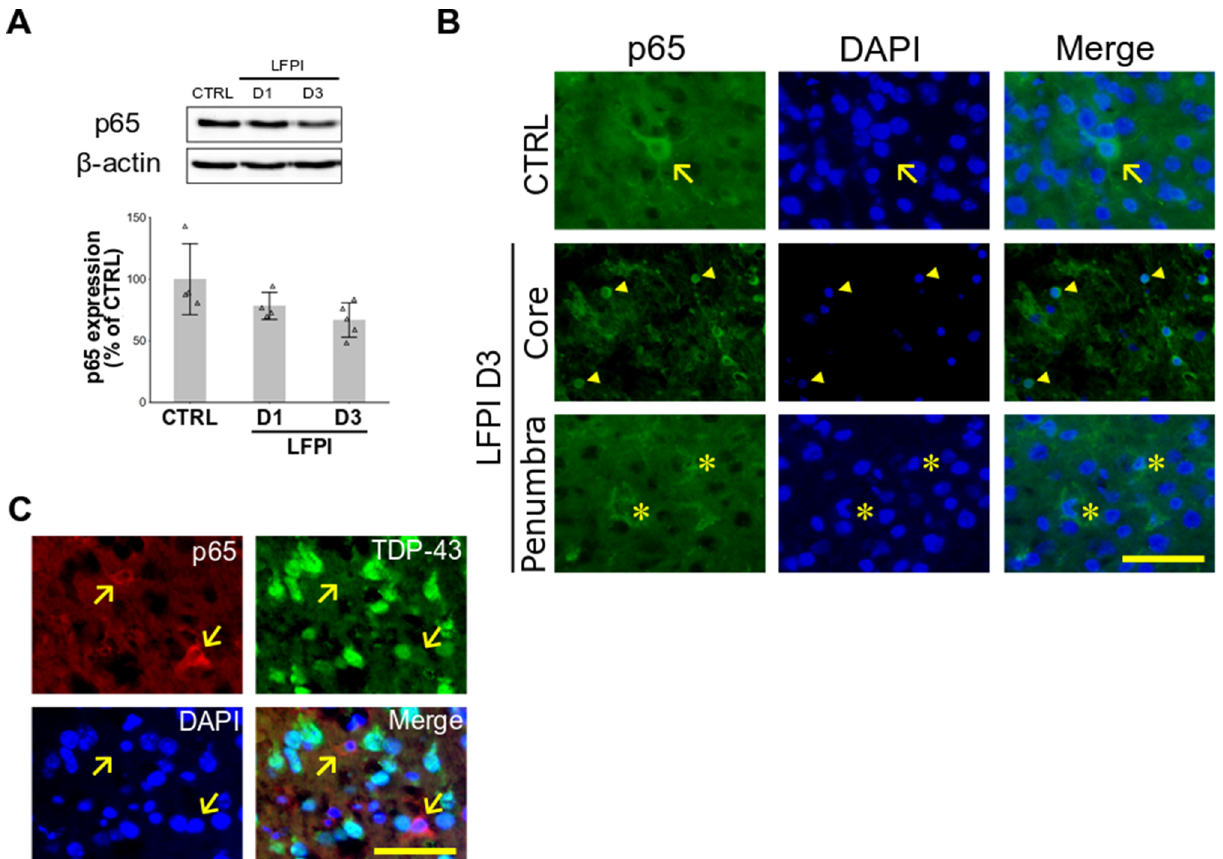
Figure 2. Changes in the cortical cytoplasmic expression of p65 subunit of nuclear factor kappa B (NF- κ B) following single moderate lateral fluid percussion injury (LFPI) in the mice: ( A ) Representative p65 and β -actin immunoblots and the bar plots of their corresponding densitometry analyses in the animals of the control group (CTRL) and the mice with brain trauma sacrificed at 1 (D1) or 3 (D3) d following LFPI are shown. In the densitometric analyses, p65 results were corrected for the values of β -actin and expressed as % of the related control group. Error bars represent ± SD ( n = 4–5 mice per group). Each triangle represents data from an individual mouse. ( B ) Immunofluorescence of the ipsilateral cortex of the control mouse and the injured animal sacrificed at 3 d after trauma using the p65 antibody. In the injured mouse, micro- photographs from the core traumatized area and the pericontusional penumbra are presented. Arrow points to a cell with neuron-like morphology and pronounced p65 cytoplasmic staining. Arrowheads point to cells characterized with nuclear translocation of p65 subunit of NF- ĸ B. Asterisks denote glia-like, p65 positive cells. ( C ) Double immunofluorescence of the ipsilateral cortex section from the brain-injured mouse sacrificed at 3 d following LFPI using the p65 (red) and TDP- 43 (green) antibodies. Arrows point to cells with diminished nuclear TDP-43 signal and pronounced p65 cytoplasmic staining. All the immunofluorescent sections were counterstained with DAPI nuclear stain (blue). Scale bars: 50 µm.